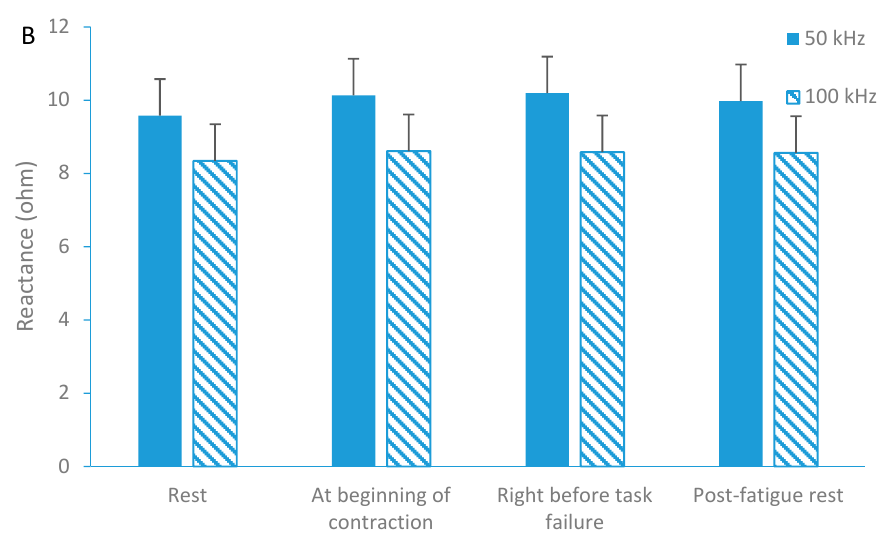
Figure 3. Resistance ( A ) and Reactance ( B ) at fatigue tests with two different frequencies (50 kHz and 100 kHz) (mean ± standard deviation, * indicates p < 0.05 between contraction conditions during fatigue task).